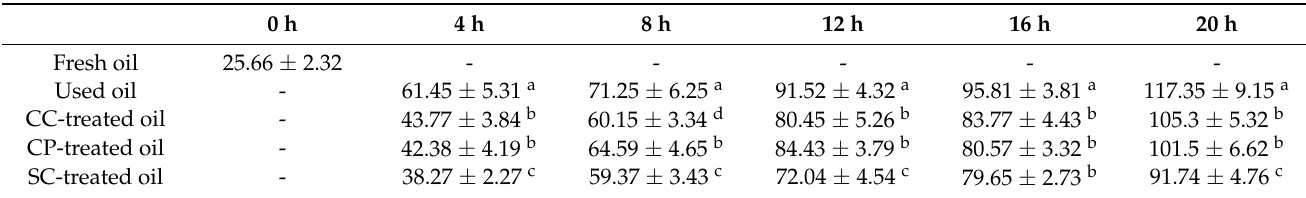
Table 6. Total oxidation value (TOTOX) of the used and treated oils with different lignocellulosic biomasses; corn cob (CC), cornstalk piths (CP) and sugarcane bagasse (SC). Means with different letters ( a , b , c , d ) within each column indicate statistically significant differences between the samples after Duncan’s analysis ( p < 0.05). The numbers 4, 8, 12, 16 and 20 indicate the frying period by (h, hours). 0 h 4 h 8 h 12